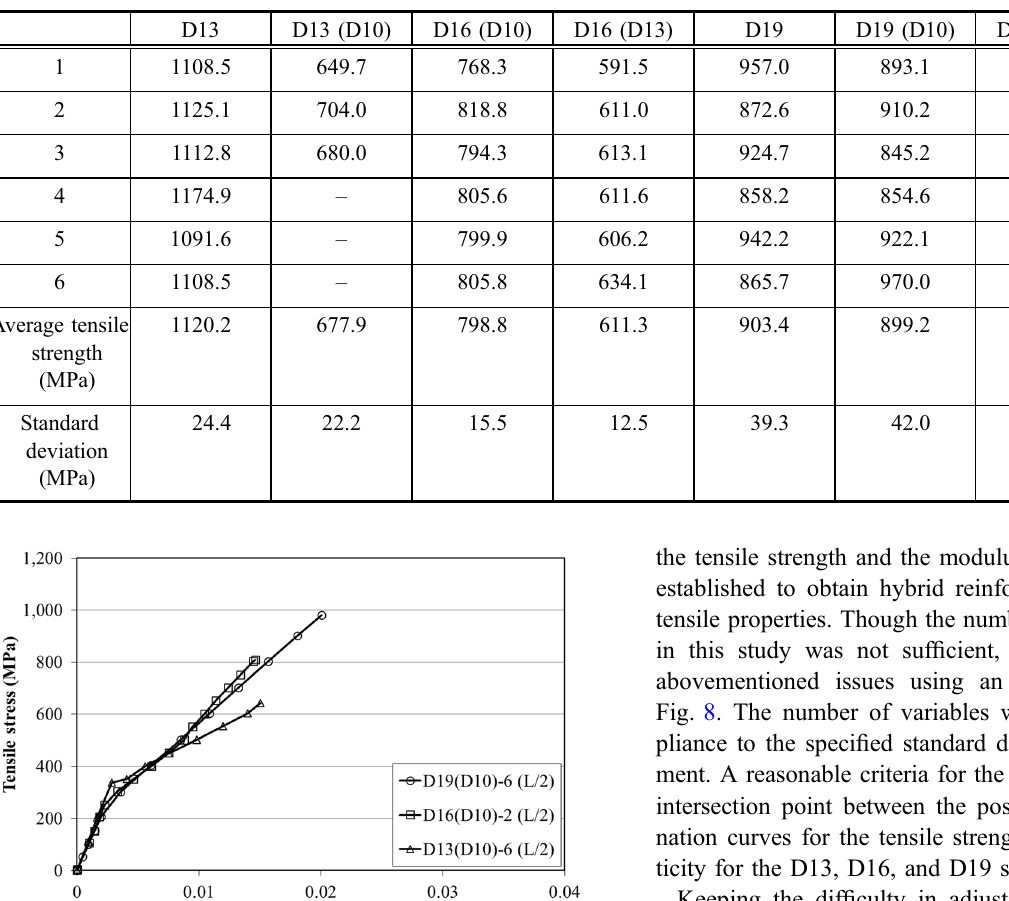
Table 2 Tested tensile strength of the GFRP hybrid